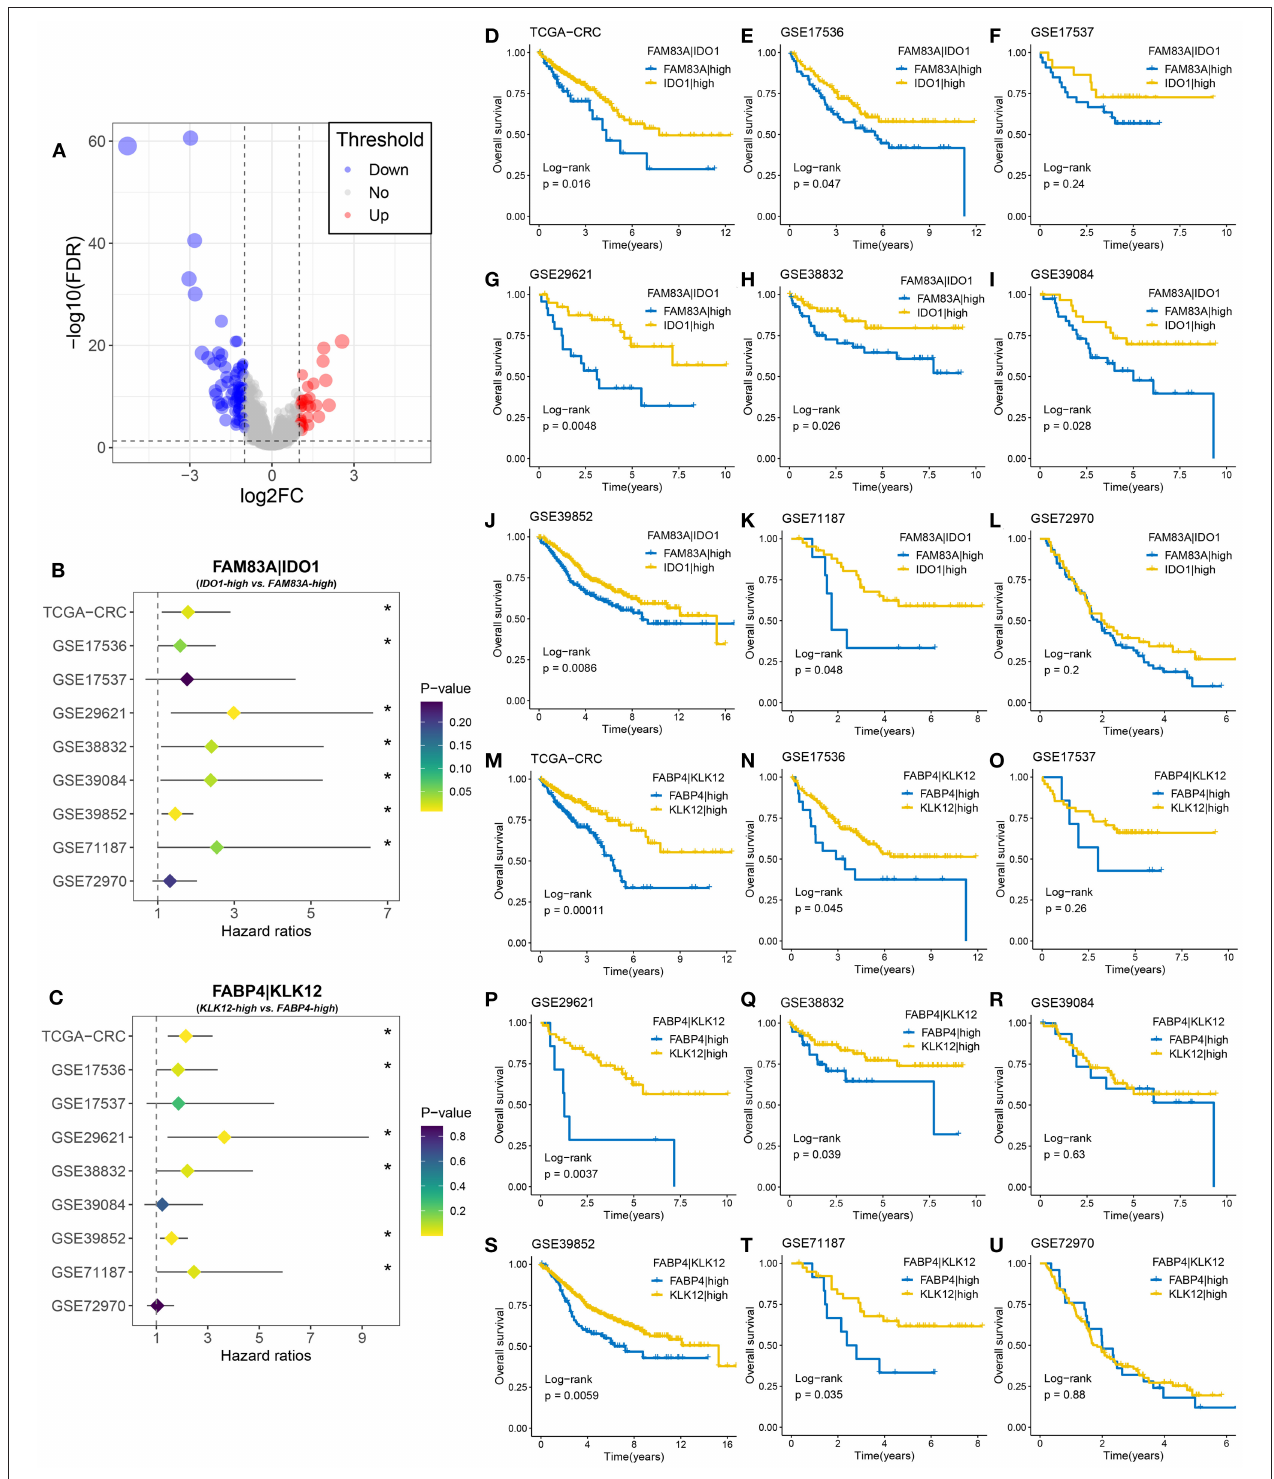
FIGURE 7 | Identification of gene pairs with the ability to predict prognosis of CRC patients. (A) Volcano plot of differentially expressed genes (DEGs) between MSC-1 and MSC-2. The abscissa is log2FC, and the ordinate is –log10 (FDR). The red and blue points in the plot represent DEGs with statistical significance (FDR < 0.05 and |log2FC| > 1). (B) Forest plot of IDO1 |high vs. FAM83A |high groups in nine cohorts. (C) Forest plot of KLK12 |high vs. FABP4 |high groups in nine cohorts. (D–L) Kaplan–Meier survival analysis for FAM83A|IDO1 in the TCGA-CRC (D) , GSE17536 (E) , GSE17537 (F) , GSE29621 (G) , GSE38832 (H) , GSE39084 (I) , GSE39852 (J) , GSE71187 (K) , and GSE72970 (L) cohorts. (M–U) Kaplan–Meier survival analysis for FABP4|KLK12 in the TCGA-CRC (M) , GSE17536 (N) , GSE17537 (O) , GSE29621 (P) , GSE38832 (Q) , GSE39084 (R) , GSE39852 (S) , GSE71187 (T) , and GSE72970 (U) cohorts. * P < 0.05.